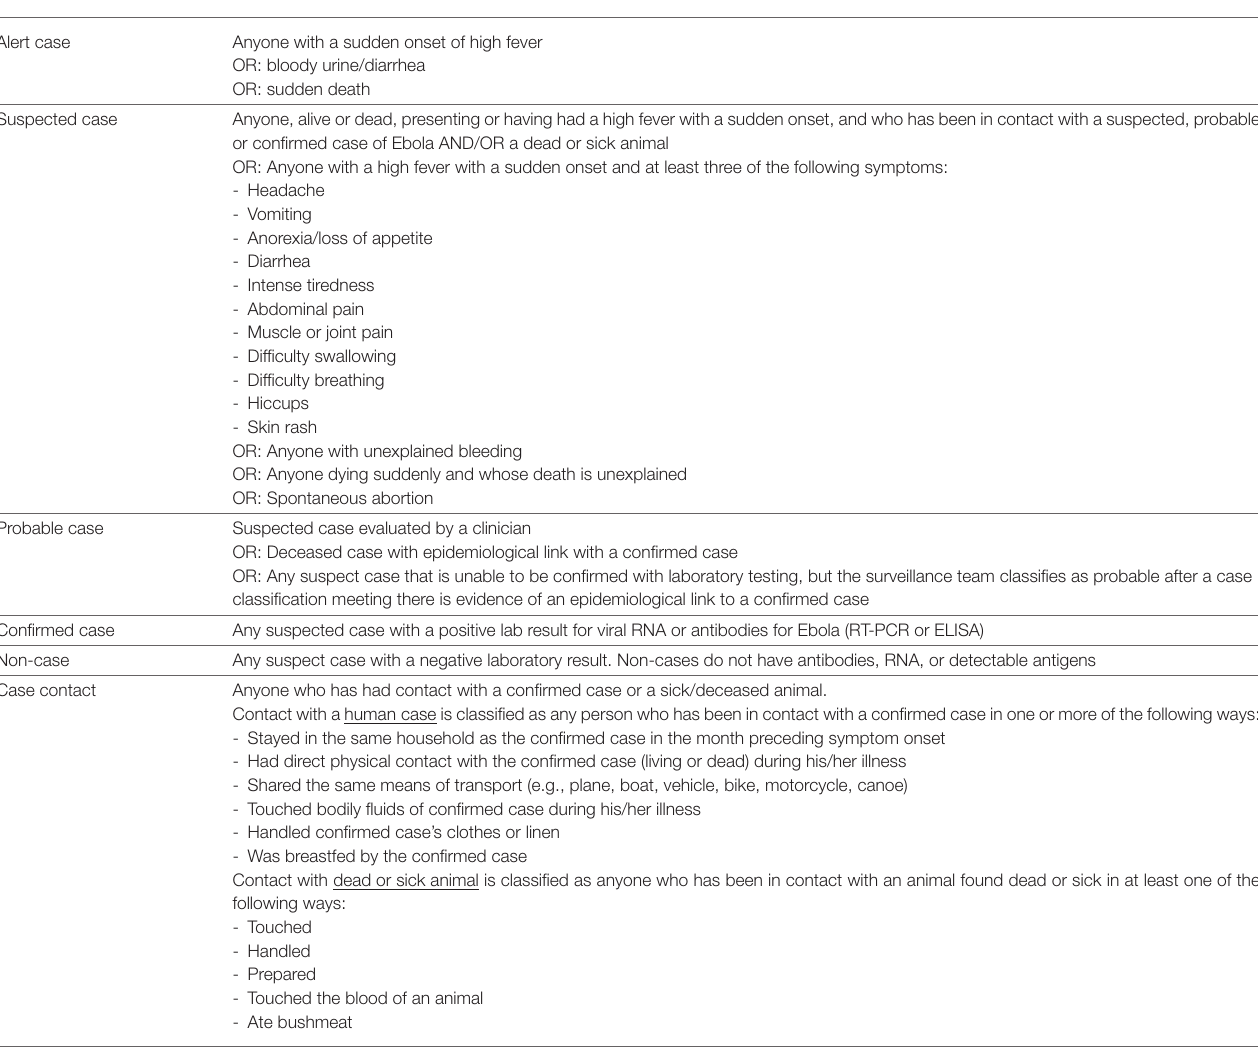
TABLE 2 | Definitions of alert, suspected, probable, confirmed, non-cases, and case contacts used in the Likati 2018 outbreak (15).